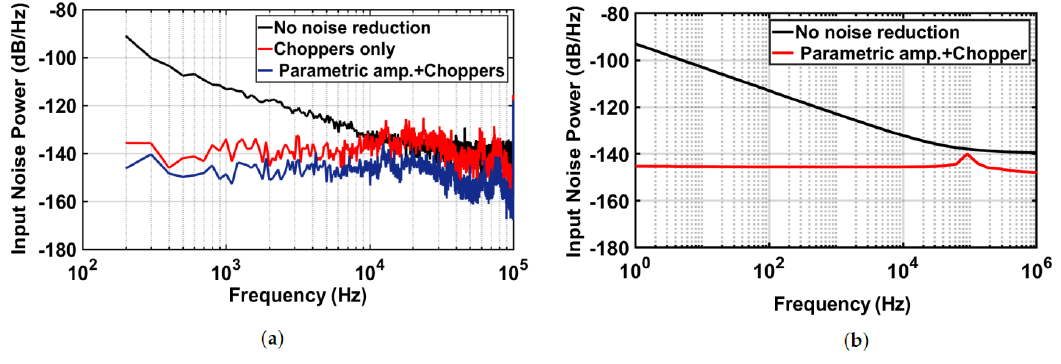
Figure 13. ( a ) Measured input noise power: without noise reduction (black), with the conventional chopper technique (red) and with the proposed parametric chopper amplification (blue), chopping f = 100 kHz; and ( b ) simulation of the input noise power of the readout chain: without noise reduction (black) and with the chopper parametric amplifier (red).